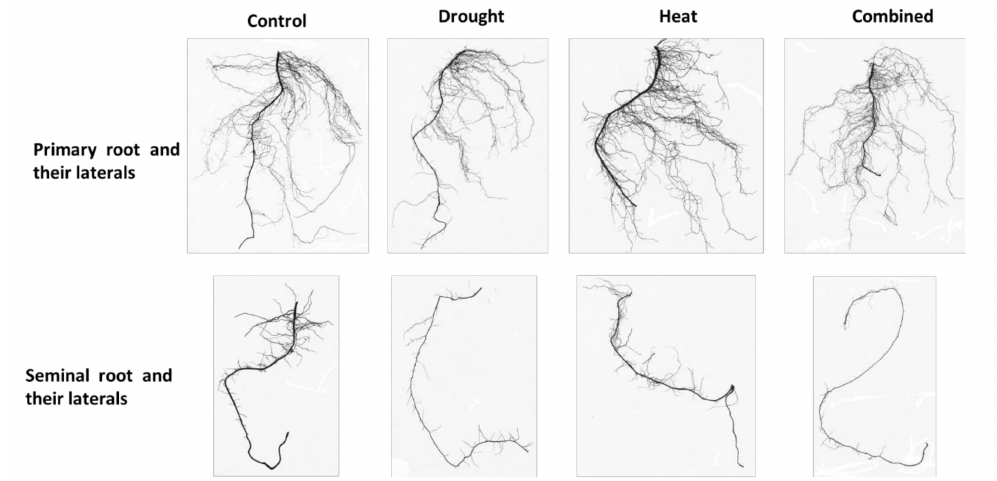
Figure 2. Primary and seminal roots and their laterals of maize seedlings exposed to drought, heat and their combina- tion (Combined).